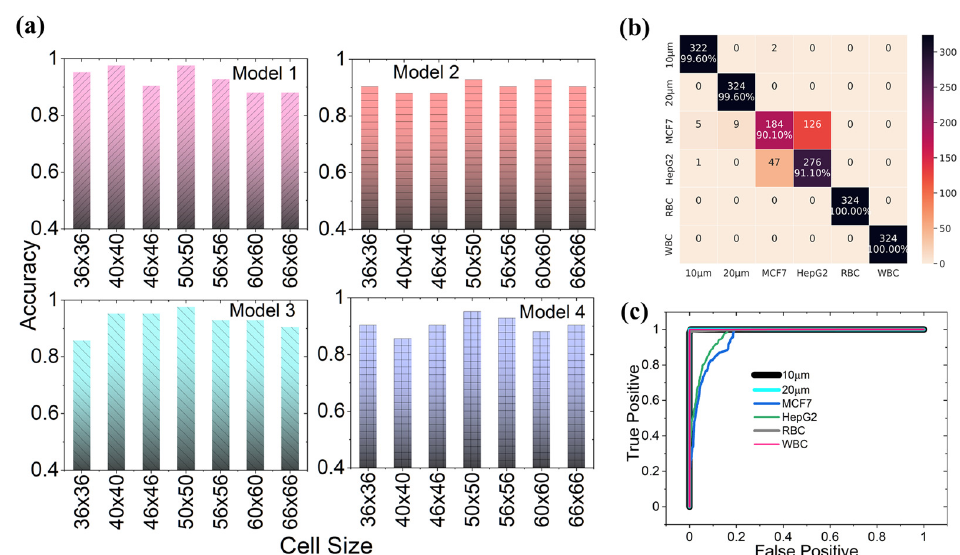
Figure 5. Results for the optimization of the CNN model. ( a ) Performance of the fine-tuned intermediate architecture. ( b ) The confusion matrix showing classification accuracy on the test dataset across all cell lines using the fine-tuned and optimized model. ( c ) The receiver operating characteristic (ROC) curve for each of the cell lines for the optimized model.